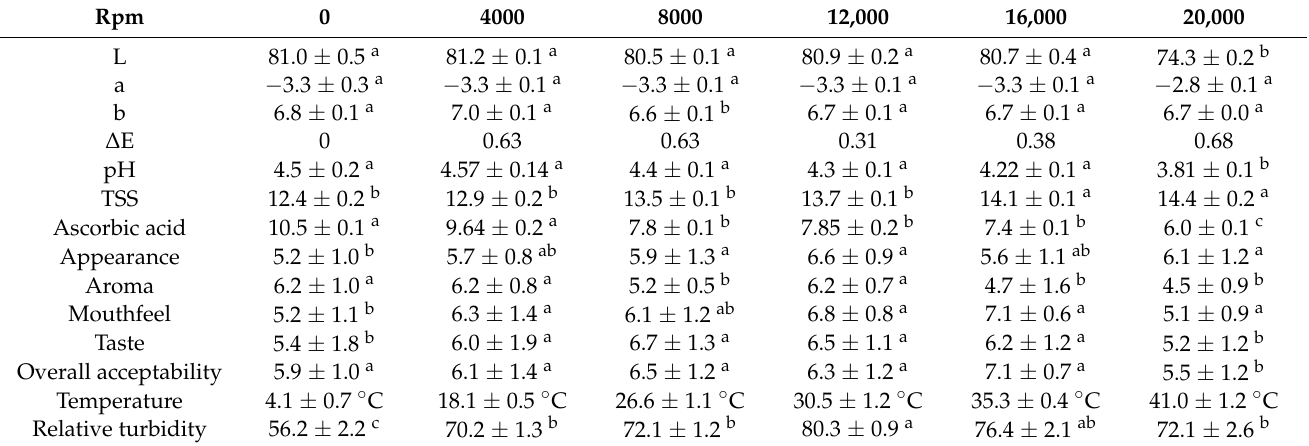
Table 1. Other physicochemical characteristics and physical properties of homogenized